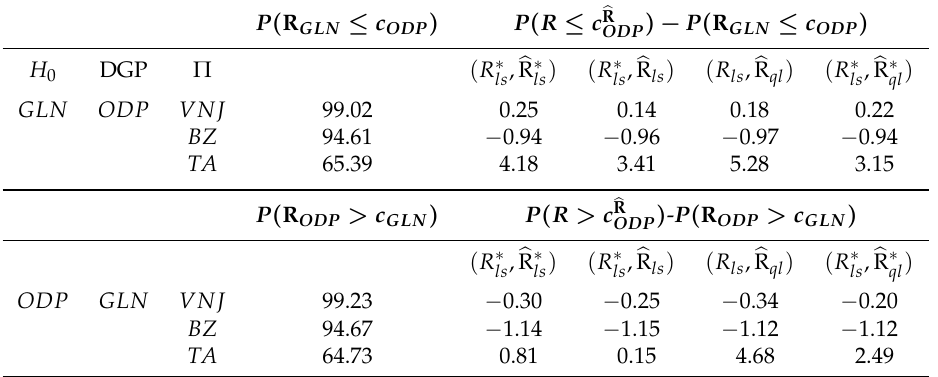
Table 2. Power in % at 5% critical values for large τ (over-dispersed Poisson DGP) and small ω 2 (generalized log-normal DGP) along with the power gap in pp for the top four performers from Table 3. DGP is short for data generating process. Based on 10 5 repetitions. s =